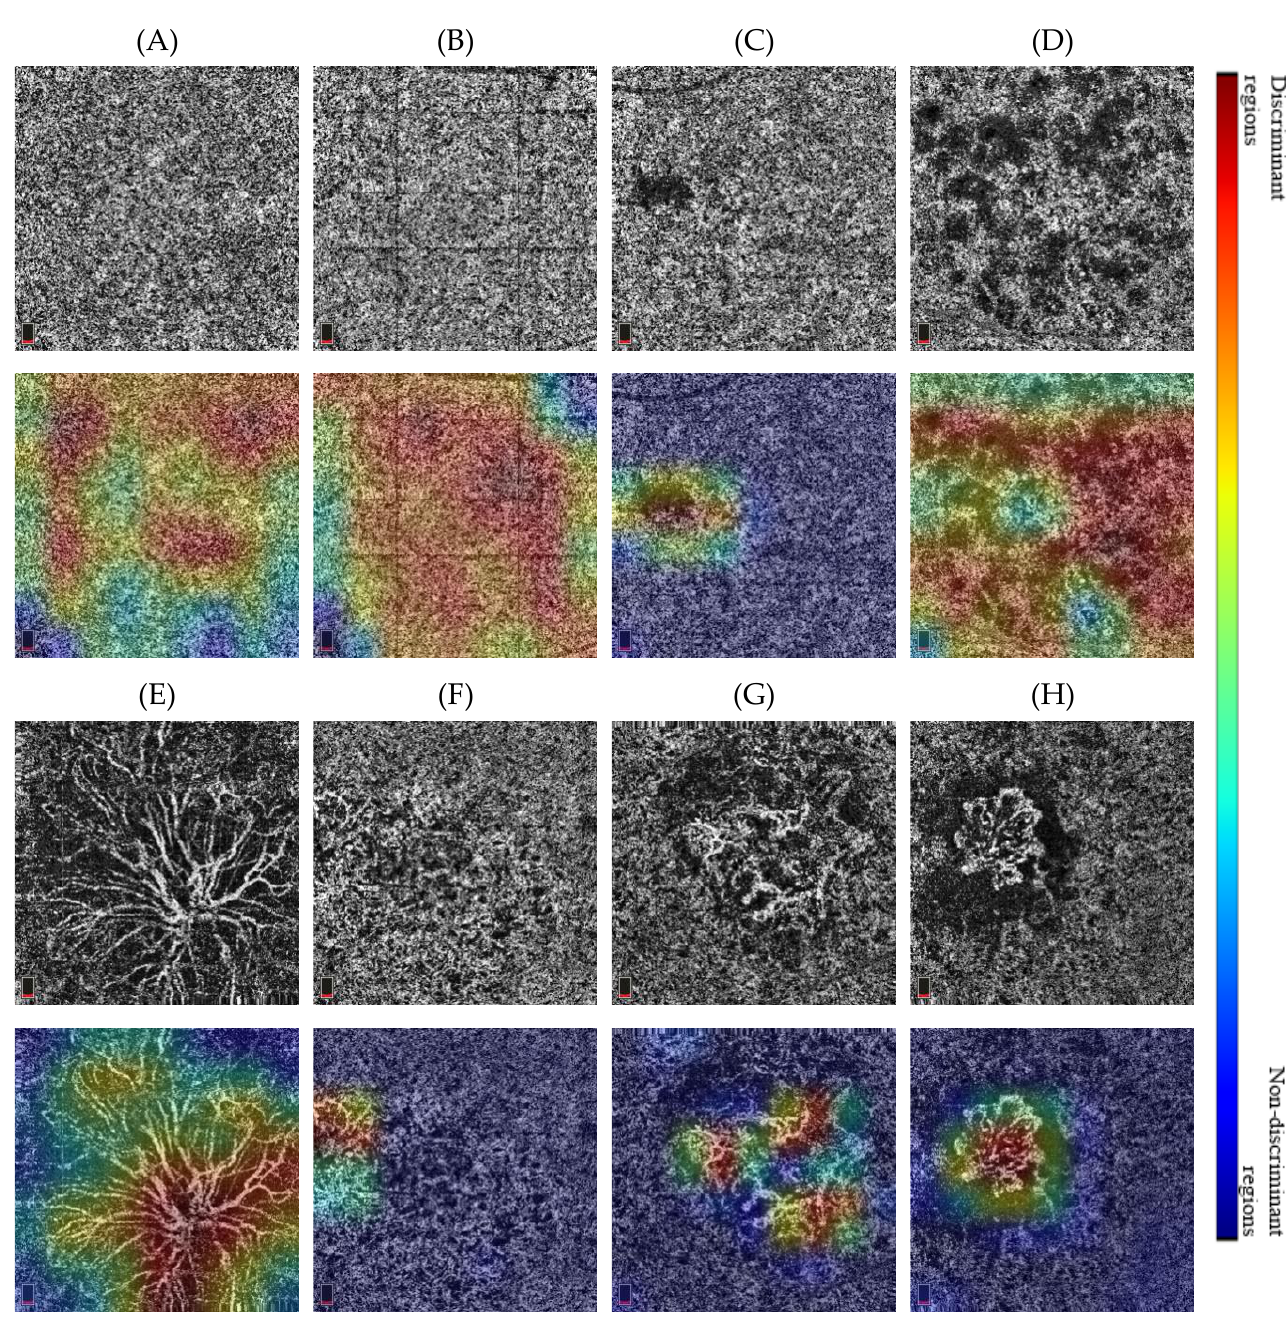
Figure 4. Grad-CAM visualizations for correct predictions by the proposed VGG19 modified model. Below each OCTA image, the corresponding Grad-CAM visualization of the CNN prediction. ( A , B ) Healthy choriocapillaris—no AMD. ( C , D ) Drusen/Choriocapillaris impairment-intermediate AMD. ( E – H ) Choroidal Neovascularization—advanced wet AMD.